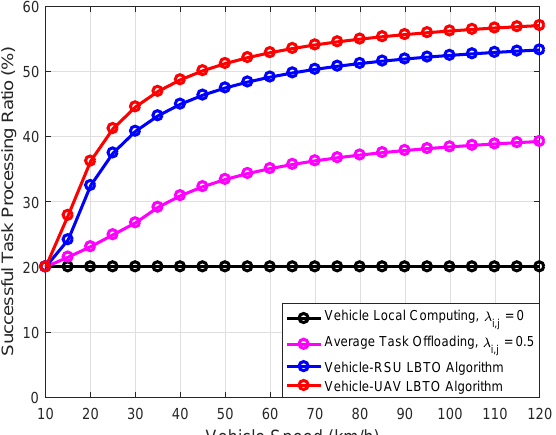
Figure 8. Comparison of the successful task processing ratio with respect to the vehicle speed under different